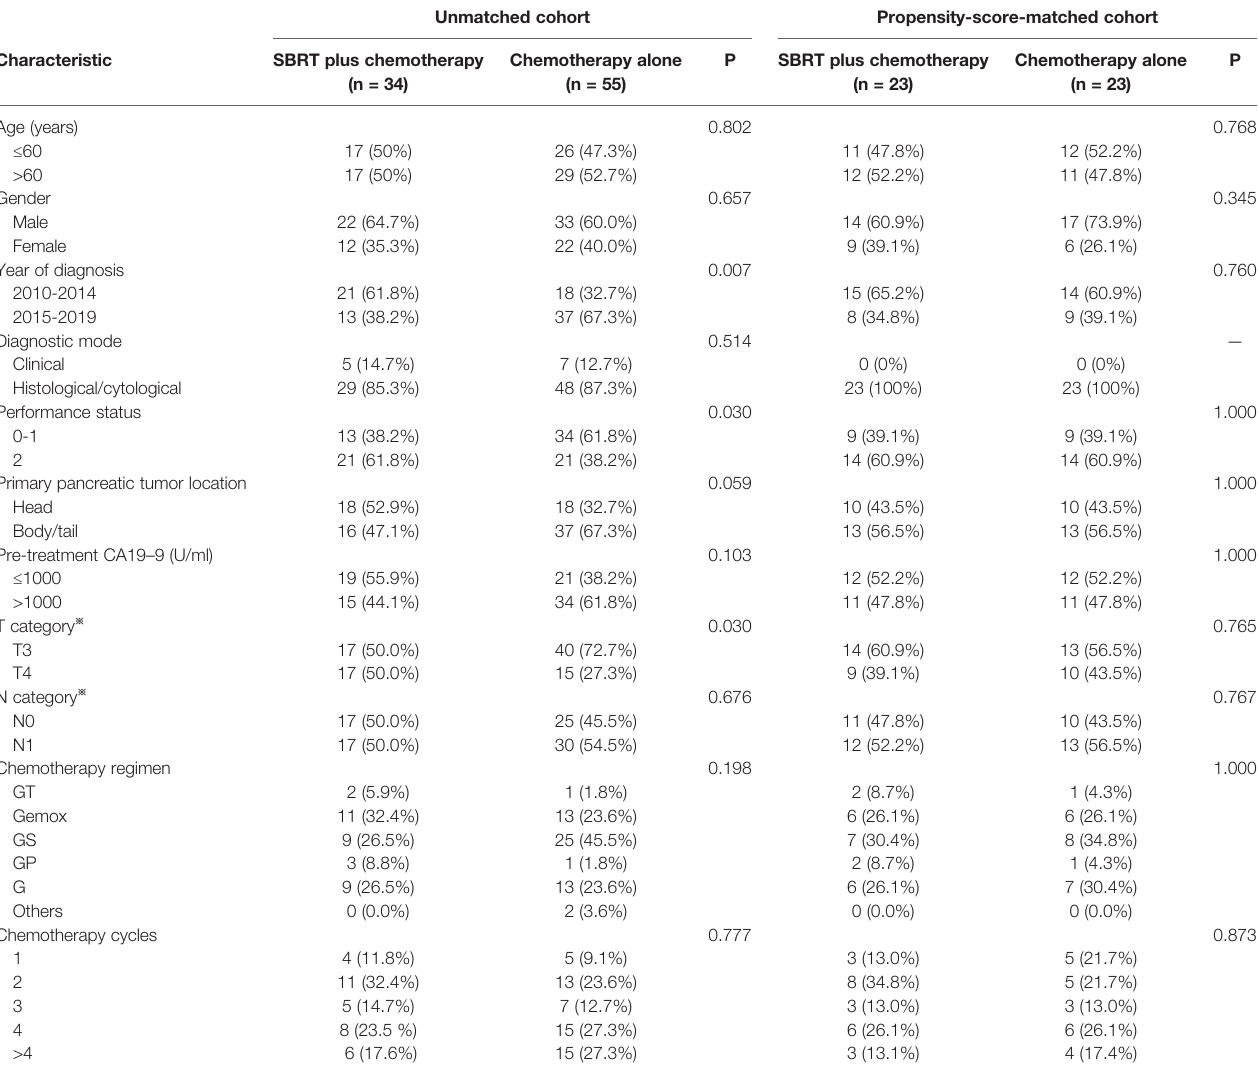
TABLE 1 | Comparison of baseline variables between SBRT plus chemotherapy and chemotherapy alone groups in the original and matched data sets. Unmatched cohort Propensity-score-matched cohort Characteristic